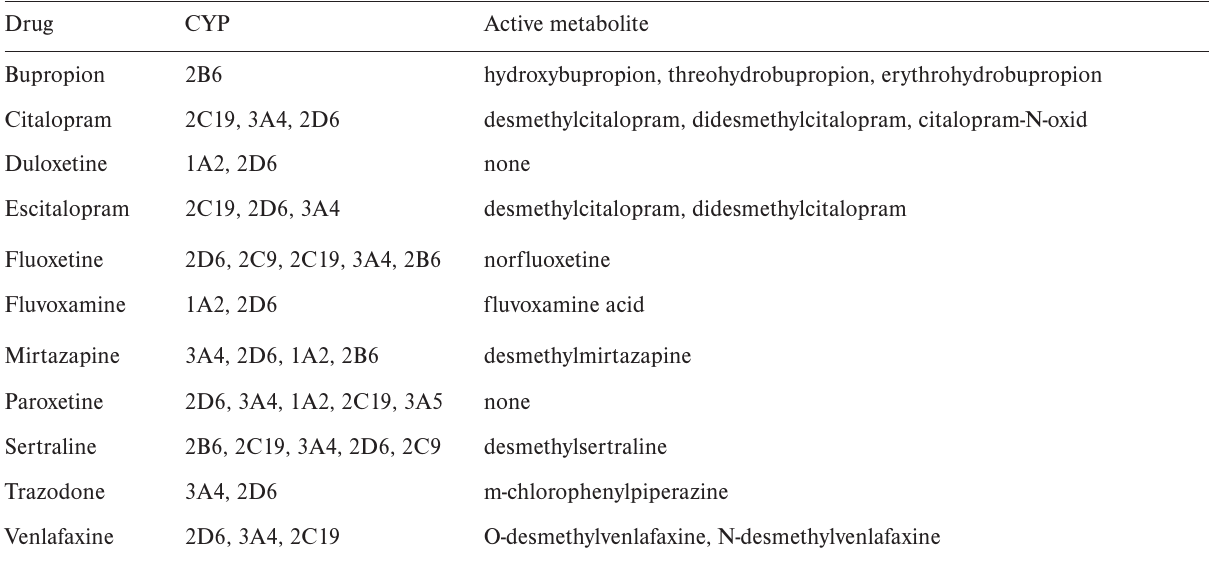
Table 2. Cytochrome P450 (CYP) forms involved in the metabolism of antidepressant drugs 9,18,54 . Drug